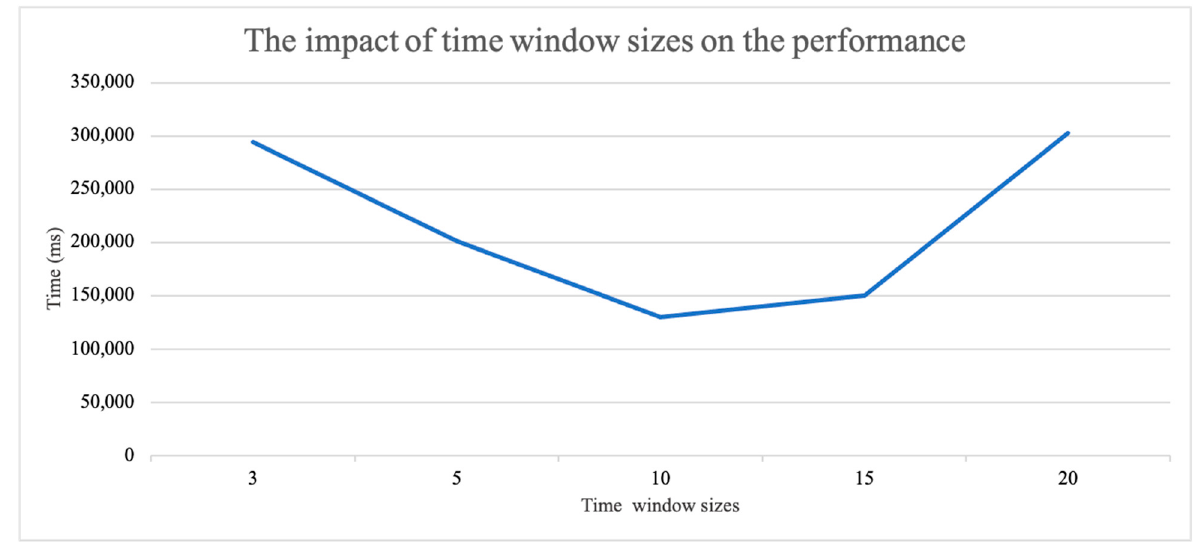
Figure 6. The time windows’ sizes impact on the performance over the dataset 4.